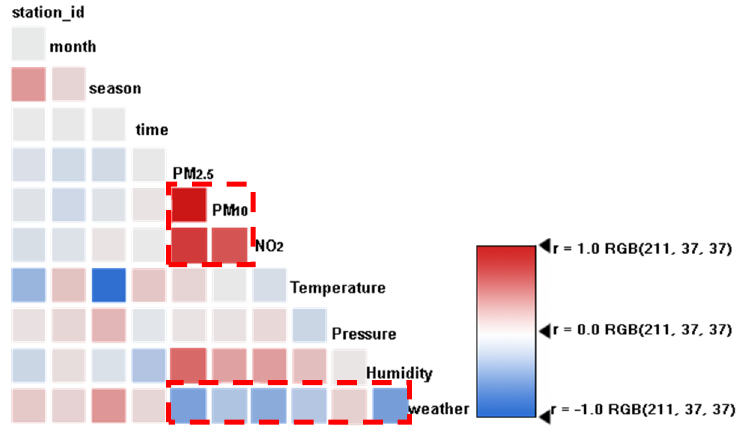
Figure 7. Correlation matrix of the U-Air data.